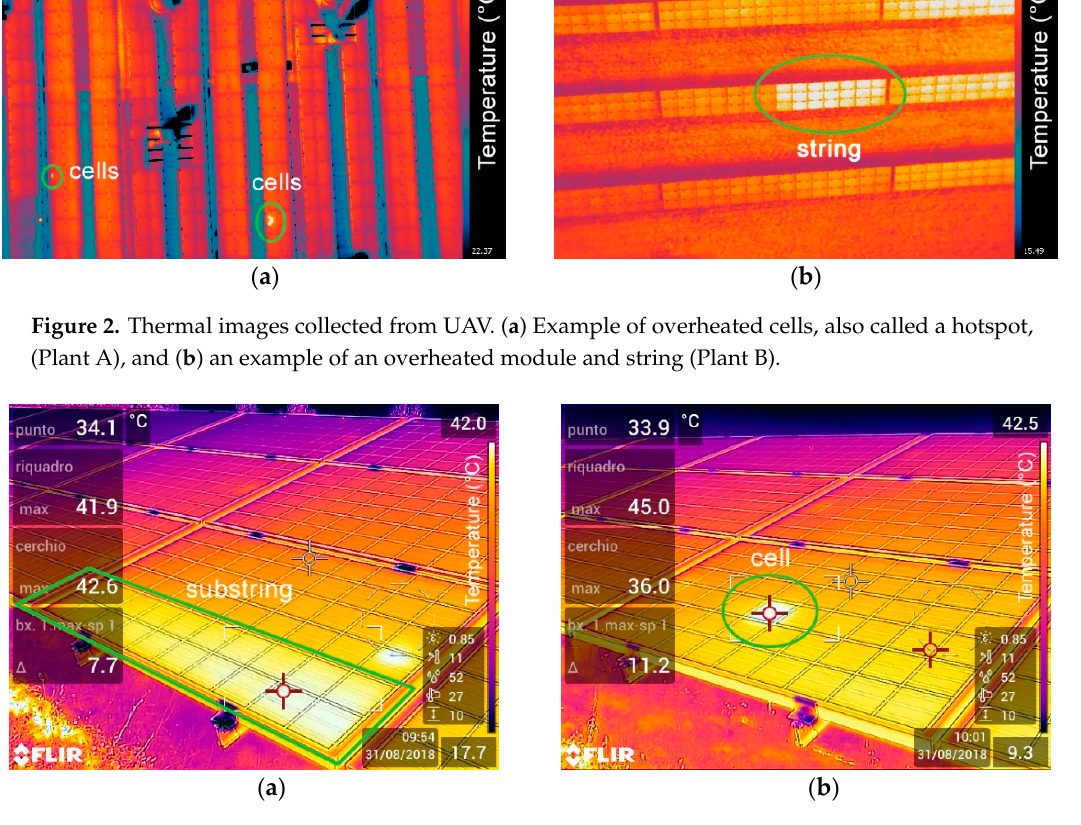
Figure 3. Thermal images collected from ground level showing overheated elements (Plant B). ( a ) is an example of overheated substring probably due to a bypass diode fault, and ( b ) is an example of overheated cell, also called a hotspot.